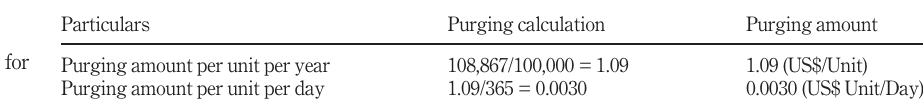
Table XII. Calculation of purging amount for the fund